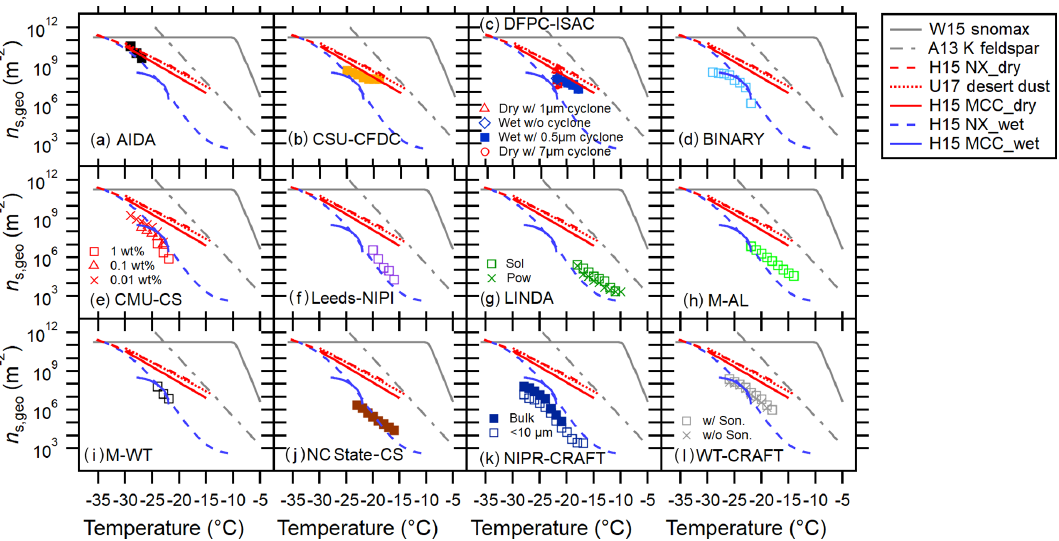
Figure 4. Intercomparison of 12 INP measurement methods for FC using T -binned n s , geo . Reference immersion freezing n s (T ) spectra are provided as in Fig. 3.